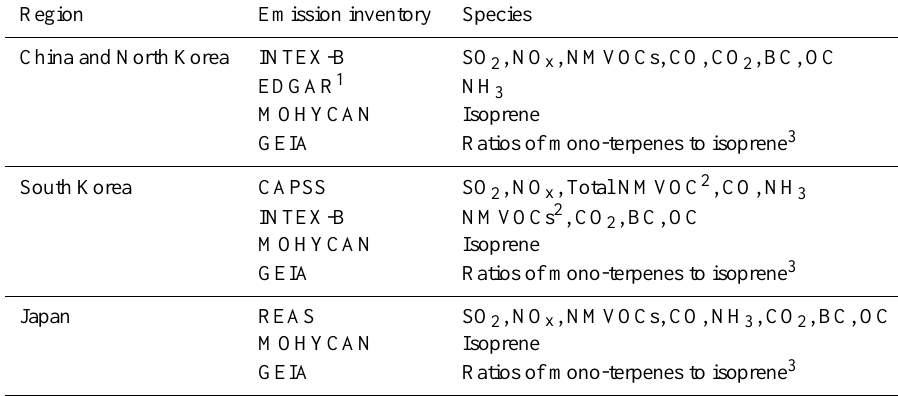
Table 1. Descriptions of the emission inventories used in this study.